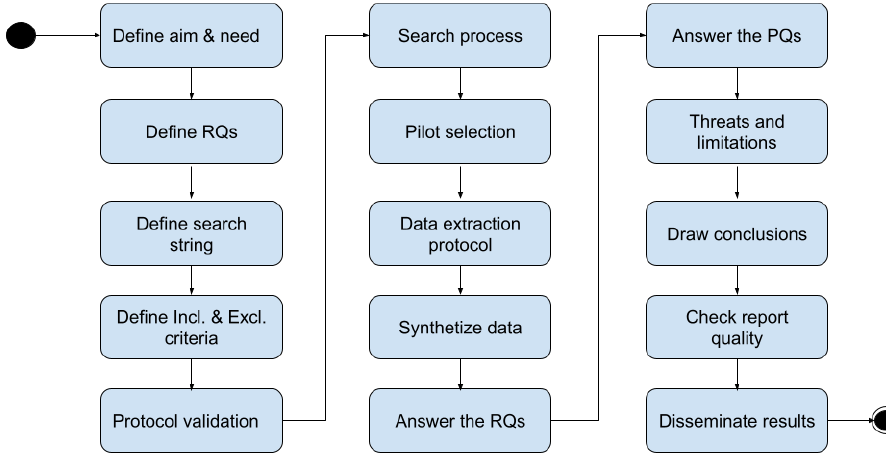
Figure 4. SMS Process and